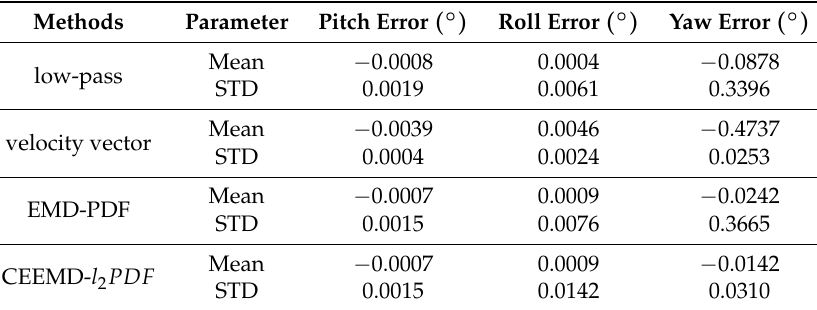
Figure 16. The alignment errors in the ship mooring experiment. Table 6. Means and STDs of alignment errors in the turntable